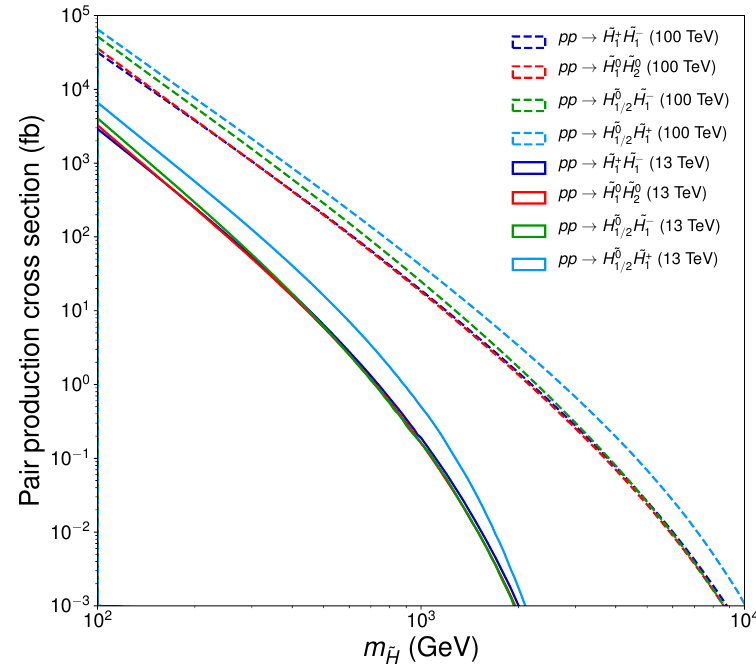
Figure 15 . 13 TeV (solid) and 100 TeV (dashed) NLO+NLL pure Higgsino pair production cross sections (assuming decoupled squarks) as a function of the Higgsino mass m ~ Resummino-2.0.1 with the PDF set MSTW2008nlo90cl . The processes shown are pp (red), pp